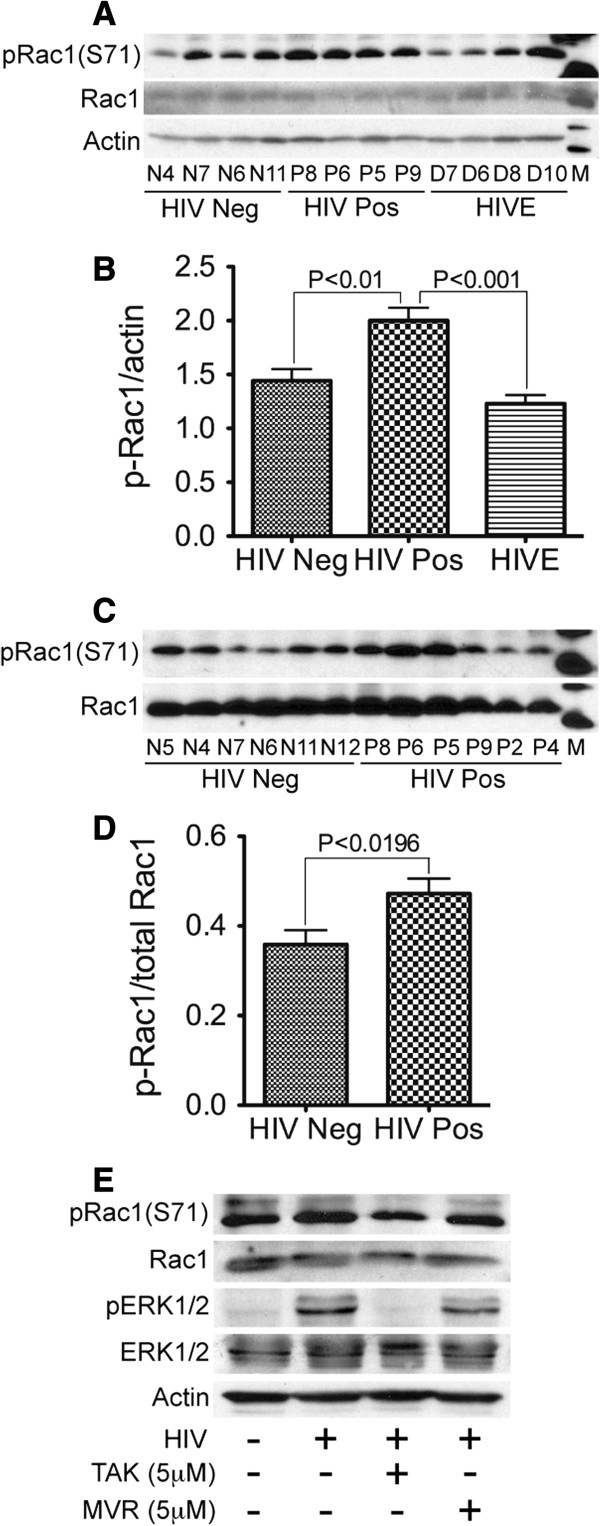
Increased phosphorylation of Rac1(S71) in brain tissues of HIV-infected humans. (A-D) Western blot analyses show increased levels of pRac1 (S71) in brain tissues of HIV-positive individuals (HIV Pos, donors P8, P6, P5, P9, P2, and P4), compared to HIV-infected patients with encephalitis (HIVE, donors D7, D6, D8, and D10) and seronegative controls (HIV Neg, donors N5, N4, N7, N6, N11, and N12). (E) Increased levels of pRac1 (S71) and pERK1 (Thr202/Tyr204) in HIV-infected monocytes co-cultured with HBMEC, compared to non-infected monocytes co-cultured with HBMEC. TAK-779 and maraviroc diminished HIV-induced phosphorylation of Rac1 and ERK1/2.